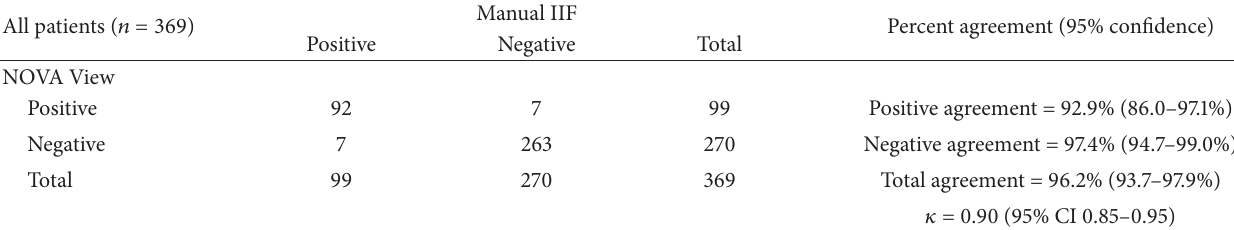
Table 2: NOVA View agreement with manual IIF: 1: 80 screening dilution.